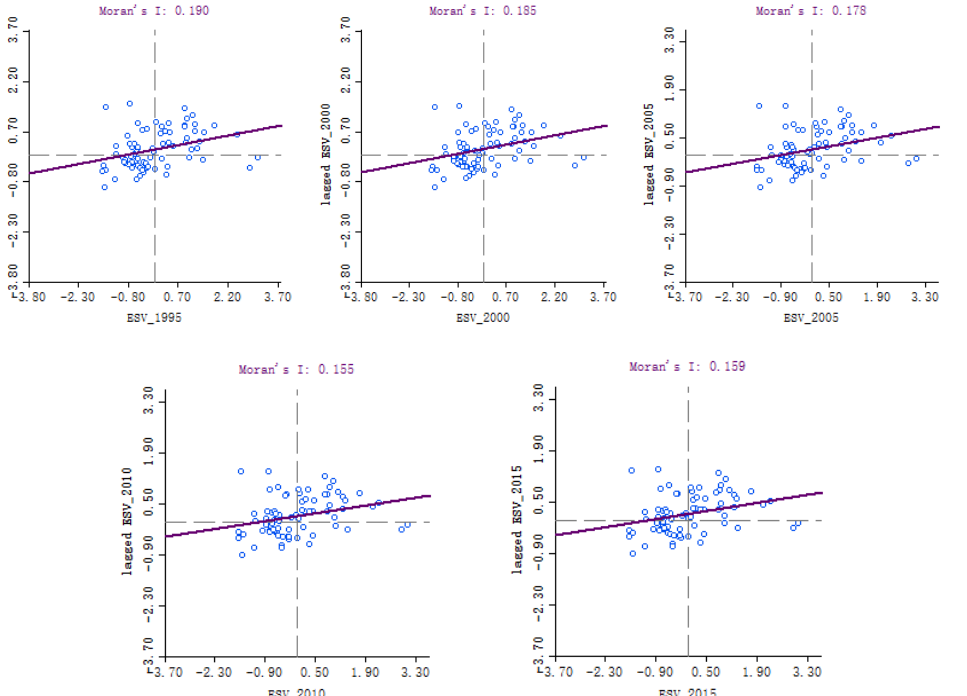
Figure 3. Global Moran’s I in Hubei province from 1995 to 2015.